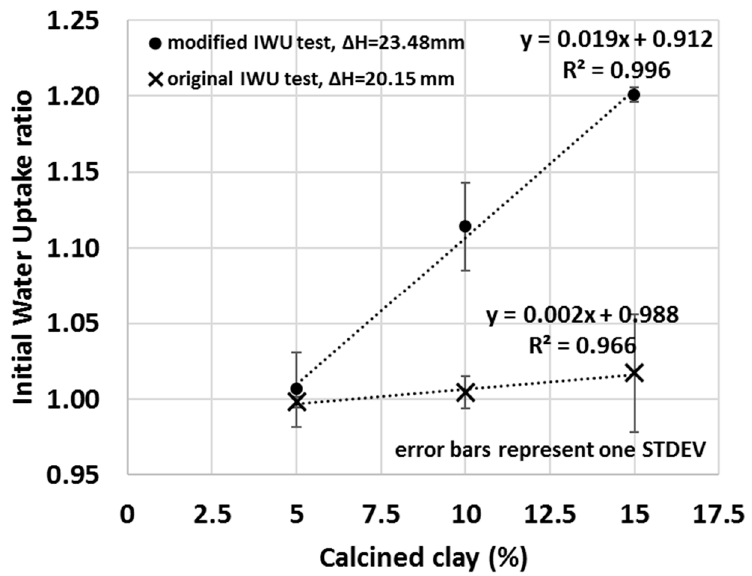
Figure 9. The impact of using a greater capillary height differential between the water level and the sample (X symbols—original height difference; • symbols—increased capillary height differential) on the IWU ratio.